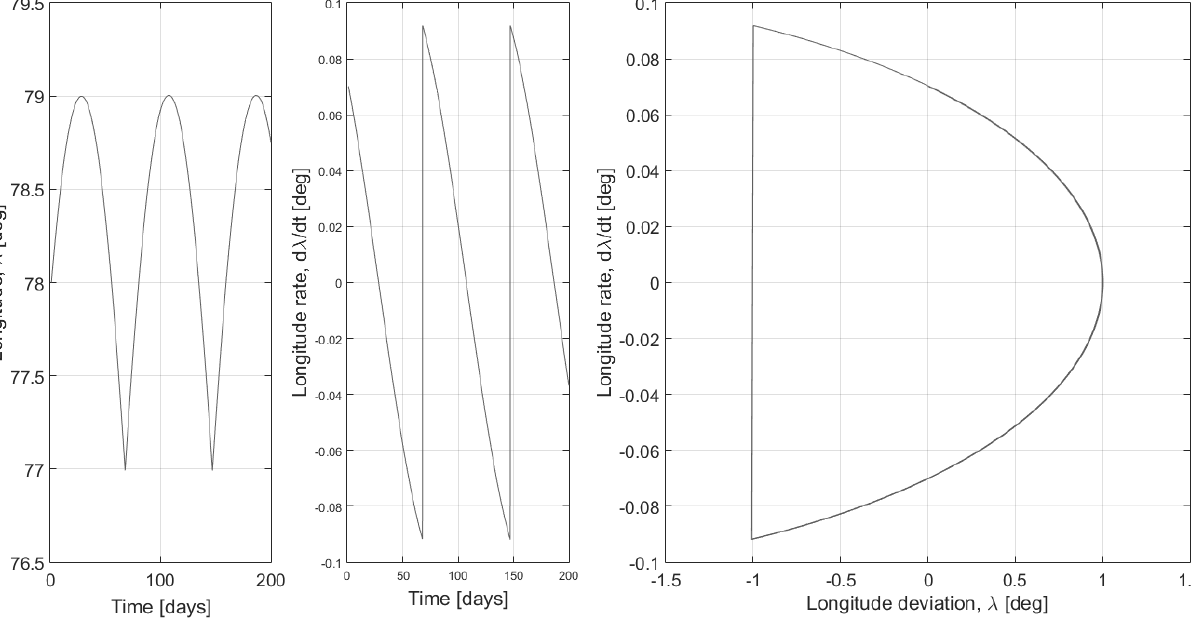
Figure 3. Simple control scheme near the stable node with ¨ λ < 0 .